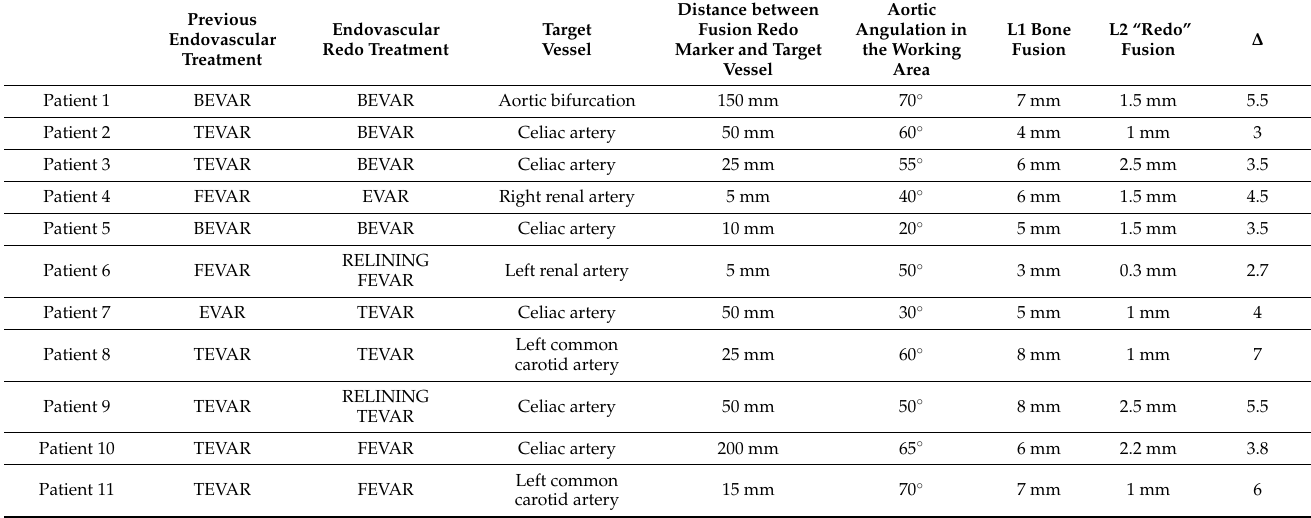
Table 2. List of patients’